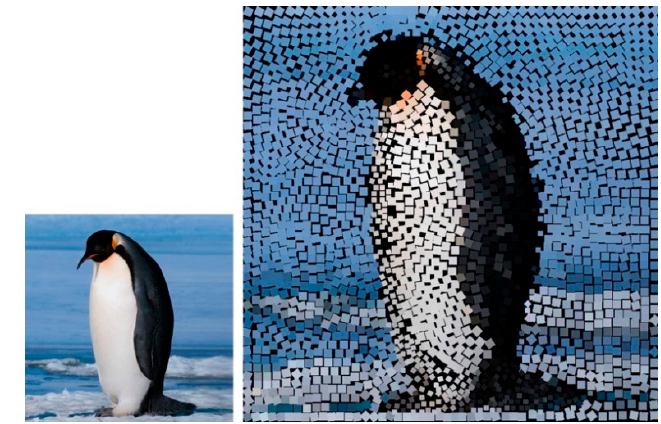
Figure 16. Converting the image into mosaic effects. The vector field controls the directions of the elements; the density graph controls the sizes of the elements.